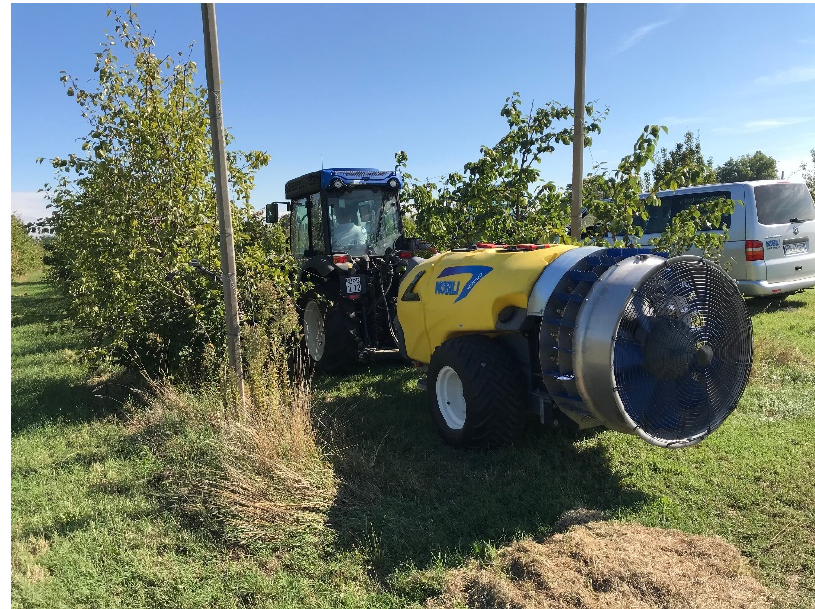
Figure 8. Orchard of the UNIBO farm during the mSprayer test. The mulcher tests were performed on a 3 ha agricultural field with old corn residuals and tall grass (SimVin in the following, Figure 9) located in San Pietro Capofiume (BO, Italy). That field was chosen because it could reproduce a comparable environment of vineyard interrow and because during the period of the tests, no orchards or vineyards with the desired conditions were available.